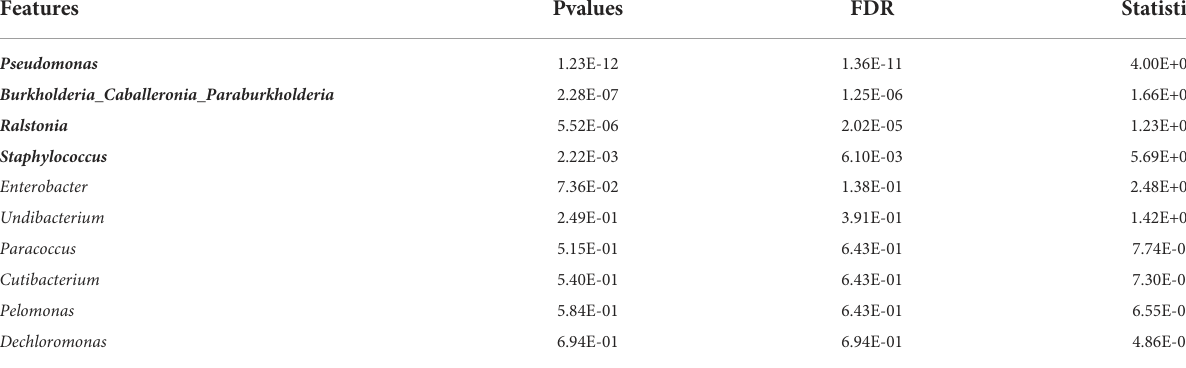
TABLE 2 Results of the univariate analysis on samples using the MicrobiomeAnalyst software.